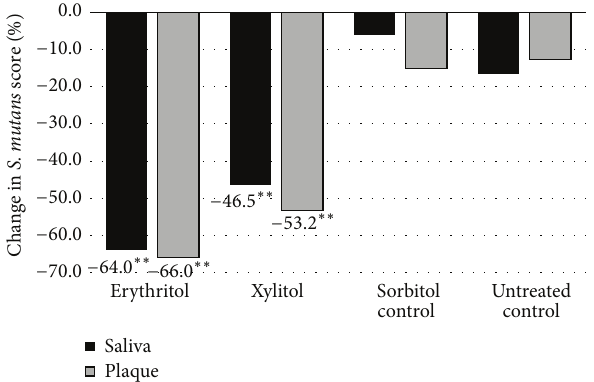
Figure 2: Percent change in salivary and plaque S. mutans score against baseline over a 6-month period in a teenage cohort con- suming erythritol-, sorbitol-, or xylitol-containing chewable tablets. Adapted from M¨akinen et al. [10]. ∗∗ 𝑝 < 0.001 when compared to baseline using a paired 𝑡 -test.